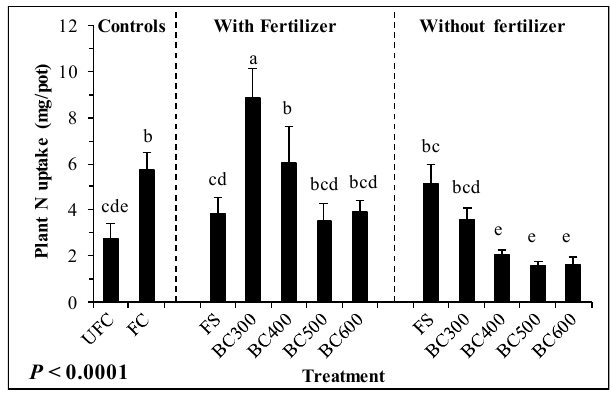
Figure 1. Response of total biomass yield of wheat grown for 5 weeks to application with and without a fertilizer of 8 t ha − 1 of four date palm residue biochars (BCs) that were produced with different pyrolysis temperatures (BC300, BC400, BC500, and BC600) and the BC feedstock (FS). Treatments also included an unfertilized control (UFC) and a fertilized control (FC). Bars sharing the same letter among treatments are not significantly different according to the Student–Newman–Keuls (SNK) test ( p ≤ 0.05). Errors bars represent the standard error of the mean ( n =4).